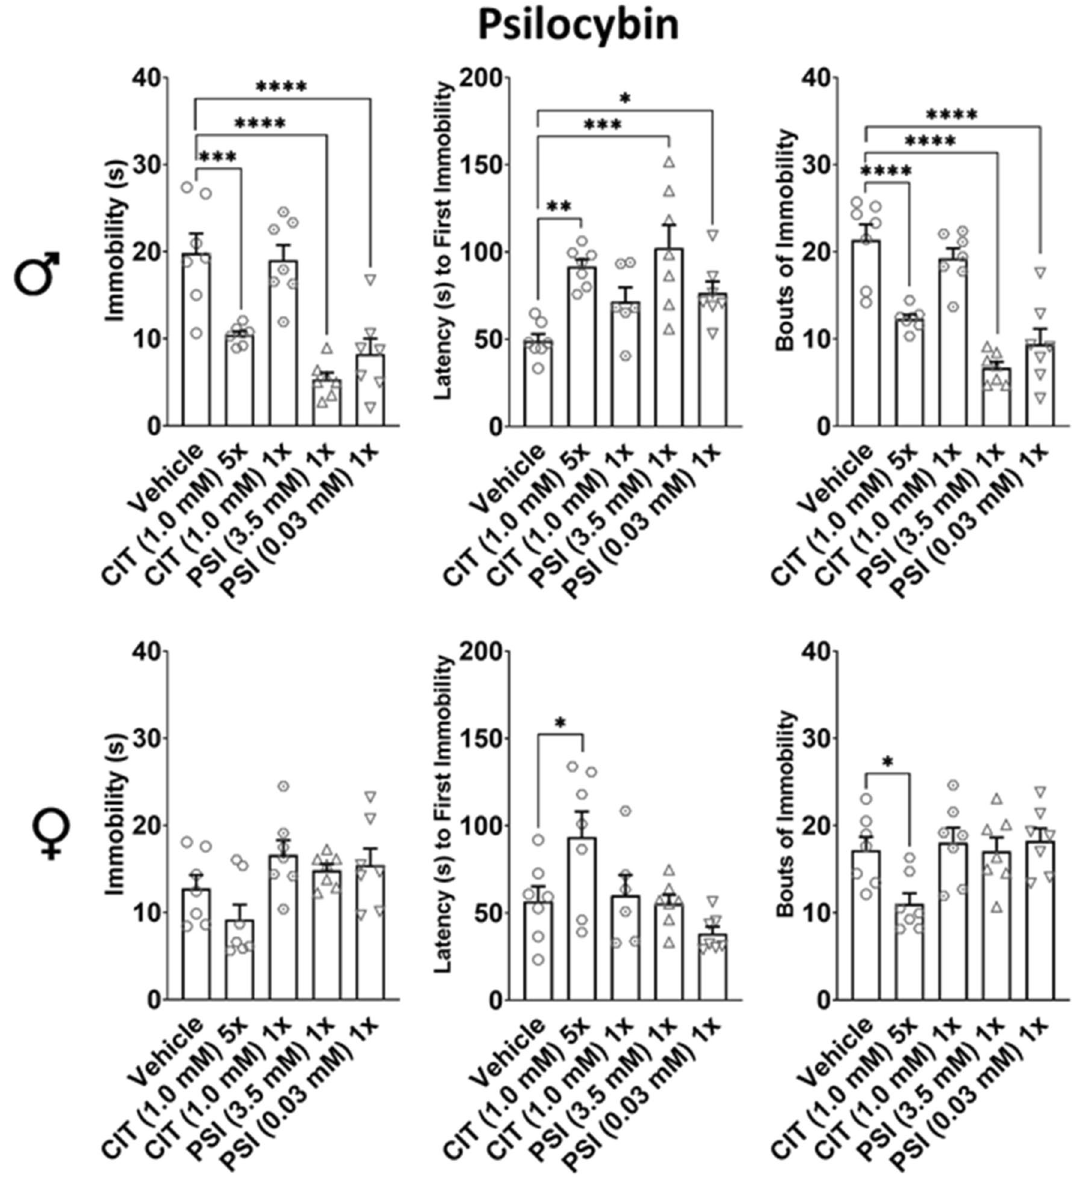
1×. Sexes were evaluated independently with one-way ANOVA and Holm-Sidak post-hoc; n = 7 for each group, and each of 7 data points is the mean of 16 flies. * p < 0.05, ** p < 0.01, **** p < 0.0001. Males given CIT 5×, and both high and low PSI were significantly less immobile than vehicle, but no differences were observed in males given CIT 1× or in any females. Males, and females given CIT 5×, and males given both high PSI and low PSI displayed greater latency to first immobility vs vehicle. Males and females given CIT 5×, and males given both high PSI and low PSI displayed significantly fewer bouts of immobility than